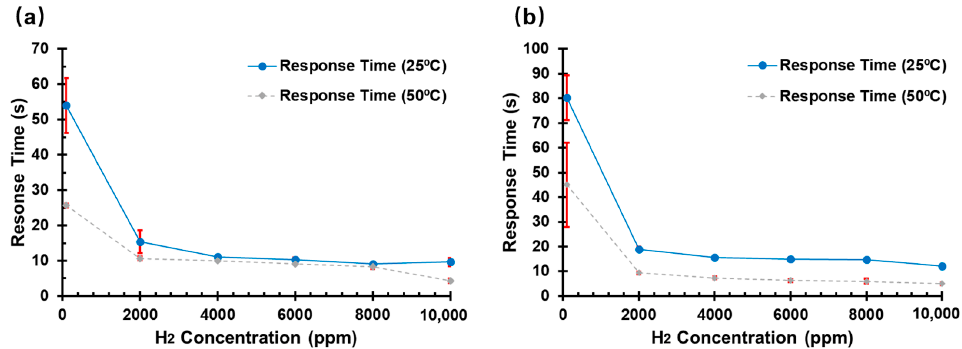
Figure 7. Response time (with standard deviation, sample number (N) = 3) of H 2 sensors based on Pd thin film on GOP substrate at various H 2 concentrations and temperatures (25 °C and 50 °C): ( a ) 8 nm and ( b ) 60 nm.